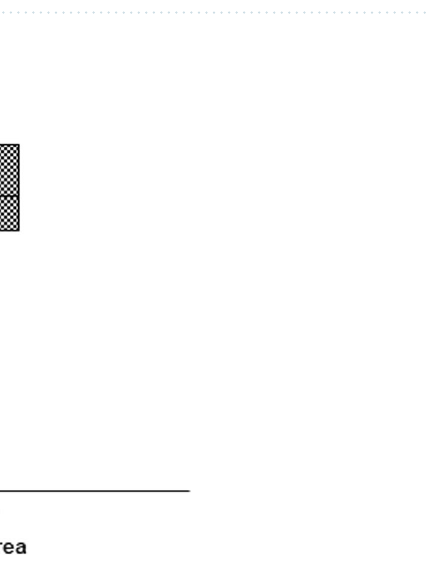
Figure 4. Ultrasonographic images of the anterior region of the joint capsule. ( A ) Short-axis image at the proximal level of the femur head (H). The fat pad (FP) is located deep to the rectus femoris (RF), medial to the gluteus minimus (GMi), lateral to the iliopsoas (Ip), and superficial to the joint capsule (Cap). ( B ) Quality map of the shear wave. Yellow and red represent shear waves with high and low qualities, respectively. ( C ) Shear-wave elastographic images. The red and bright colors represent high shear wave velocity, and blue and dark colors represent low shear wave velocity. Sa sartorius, TFL tensor fasciae latae; Yellow circles: measurement points of the shear wave velocity; Lat lateral, Med medial.